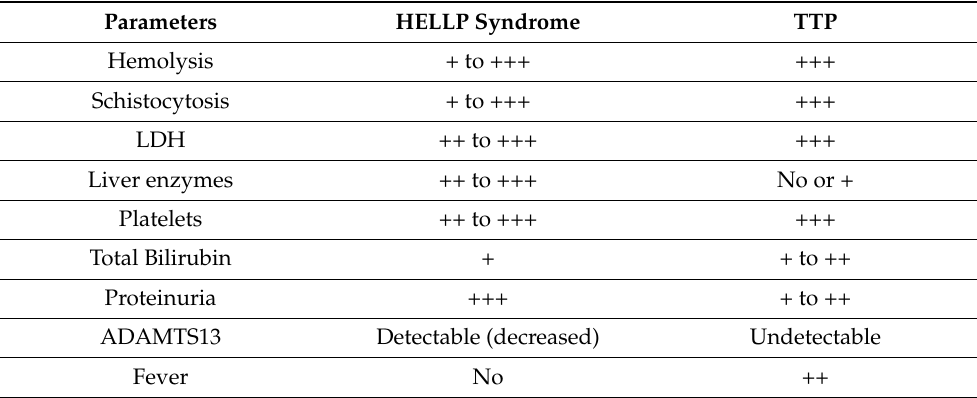
Table 3. Comparison between HELLP syndrome and TTP in terms of various clinical and laboratory parameters, +: mild, ++: medium, +++: severe